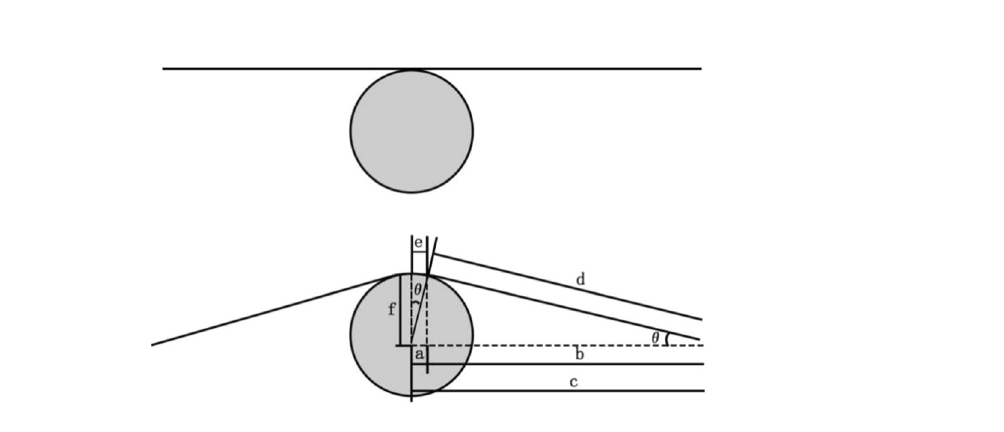
Figure 7. Analysis of the process of the conductor passing the